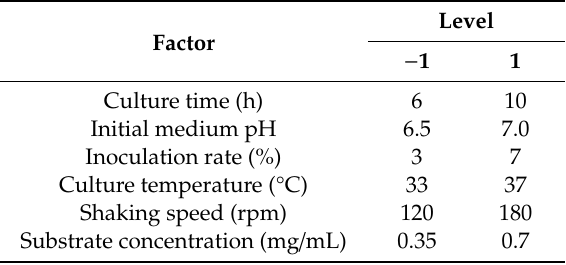
Table 8. Parameters and levels setting in PB